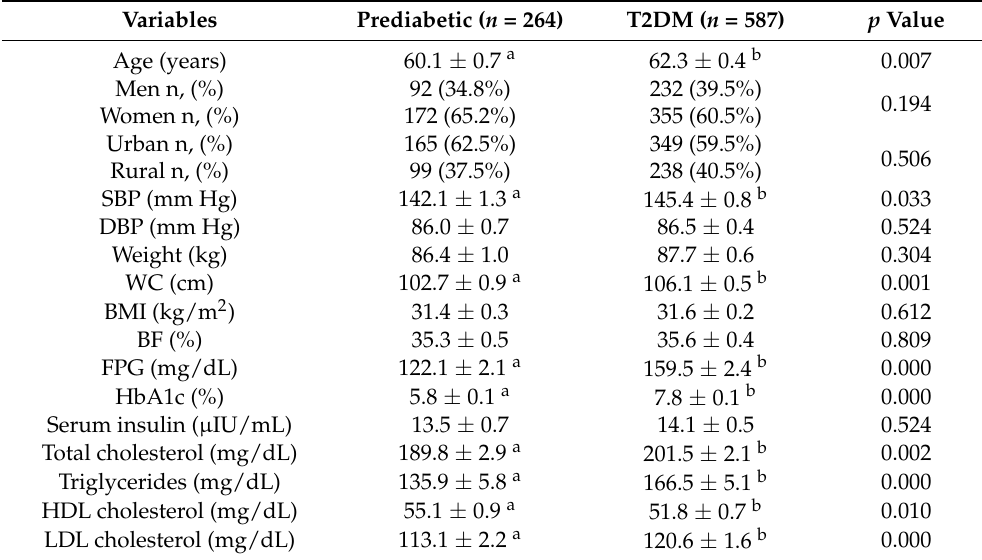
Table 1. General characteristics, anthropometric measurements and biomarkers of study